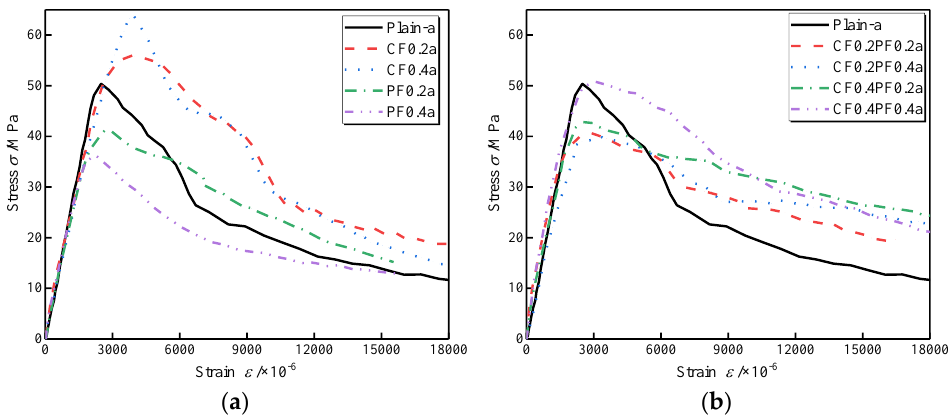
Figure 4. Effects of CF and PF on the compressive stress – strain curves of LWAC (W/B = 0.27): ( a ) fibers in single form; ( b ) fibers in hybrid form.